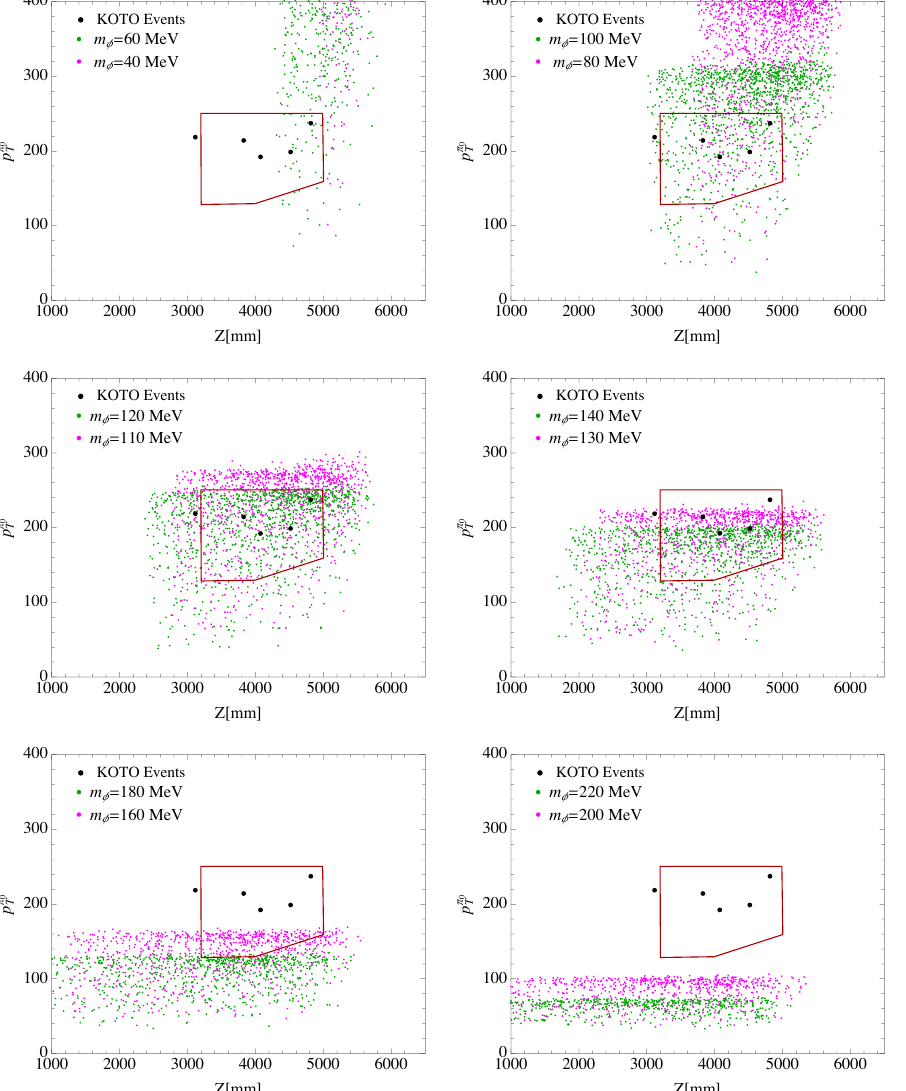
Figure 13 . The expected event distribution of K L ! (cid:27)(cid:31) decays for di(cid:11)erent mass points m (cid:30) (cid:17) m (cid:27) = m (cid:31) . We simulate 10 4 decays for each mass point, reconstruct the vertex and momentum, and apply the kinematic cuts of the KOTO K L ! (cid:25) 0 (cid:23) (cid:22) (cid:23) analysis. The KOTO signal region is delimited in red, as a function of the position of the vertex, Z , and of the reconstructed di-photon transverse momentum, p (cid:25) 0 . T